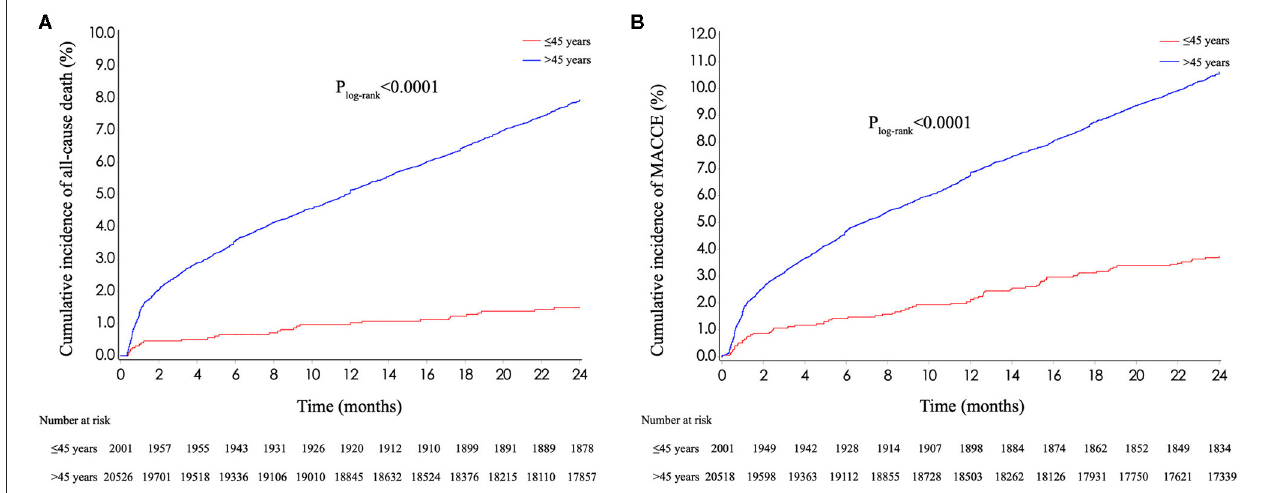
FIGURE 2 | Kaplan–Meier curves stratified by age. (A) Kaplan–Meier curves for all-cause death stratified by age. (B) Kaplan–Meier curves for MACCE stratified by age. MACCE, major adverse cardiac and cerebrovascular events.